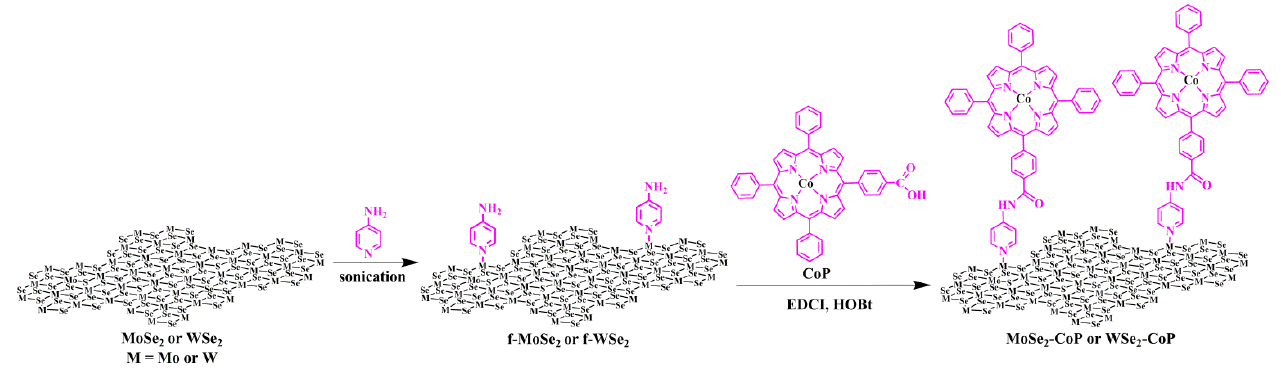
Figure 1. Synthetic illustration for the functionalization of MoSe 2 and WSe 2 and subsequent preparation of MoSe 2 -CoP and WSe 2 -CoP. tion of MoSe 2 -CoP and WSe 2